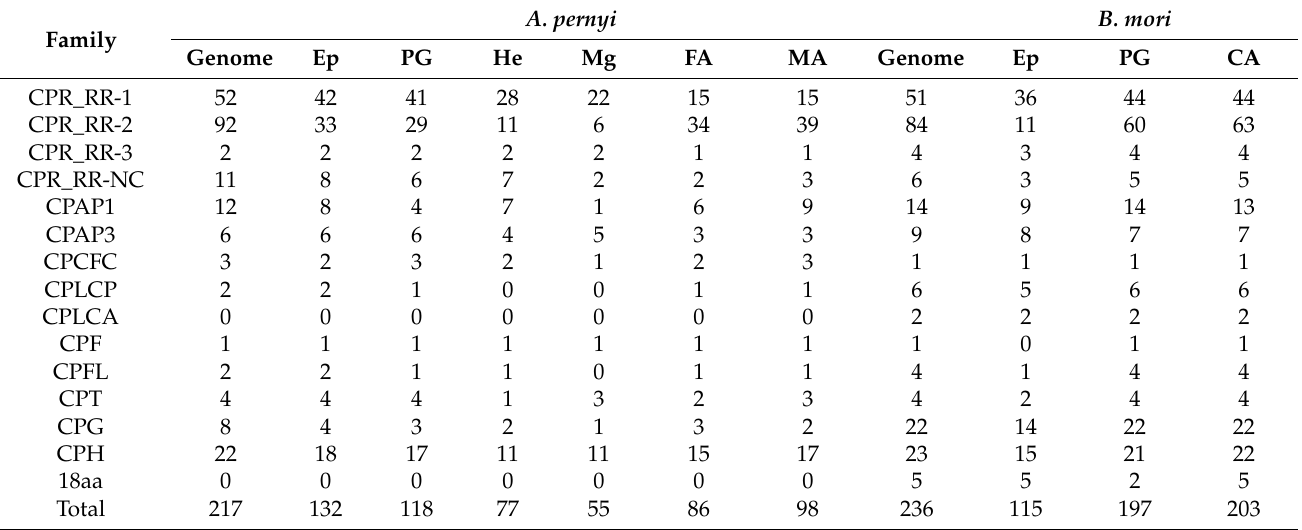
Table 1. The number of cuticular proteins identified in the genome and expressed in the epidermis and non-epidermis tissues/organs of A. pernyi and B. mori . A total of 217 CP genes were identified in the genome of A. pernyi , and 236 CP genes were retrieved in the latest genome assembly of B. mori . The number of CP genes expressed was calculated based on the transcriptomic data. Ep, epidermis; PG, prothoracic gland; He, haemolymph; Mg, midgut; FA, female antenna; MA, male antenna; CA, corpus